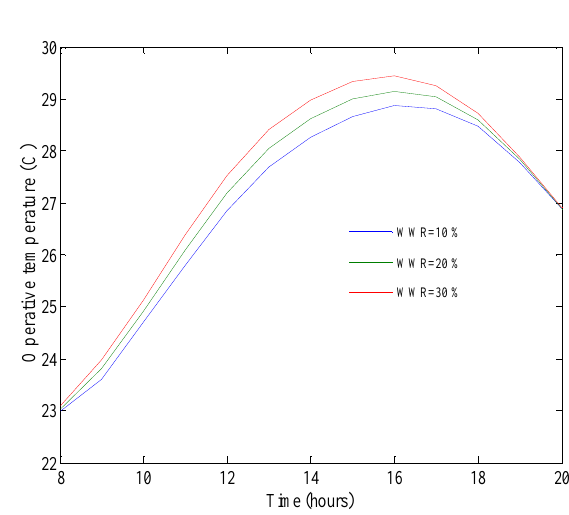
Figure 2. . Evolution of operative temperature during a day.